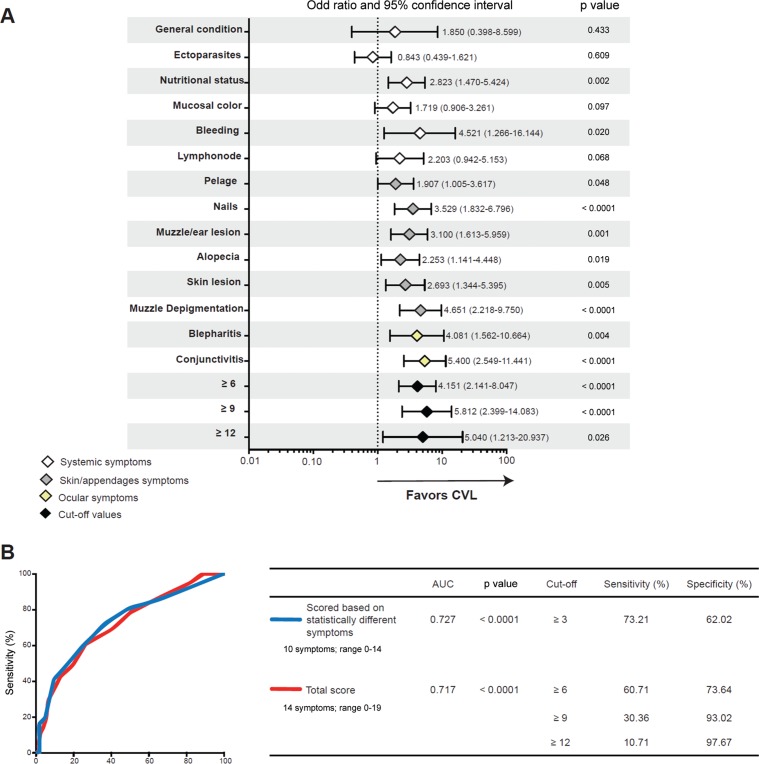
: association of clinical signs and clinical scores with canine visceral leishmaniasis (CVL). Univariate logistic regression analyses were conducted to estimate the association of each sign [based on median values or cut-off values (≥ 6, ≥ 9, and ≥ 12)] with CVL (A). Yellow-coloured items are ocular signs, grey icons are skin/appendage signs, white items are systemic signs, and black ones represent random cut-off values for the total clinical score (range, 0-19). Receiver operator characteristic (ROC) curves of the total score (red line) and the score based on statistically significant different signs (based on the analysis in A; blue line) for discriminating between dogs with and without CVL are shown in B. AUC, area under the curve. The cut-off values for the scores were established using C-statistics and are shown in the table (B). The odds ratios (OR), respective 95% confidence intervals (95% CIs), and p values are shown in each panel.